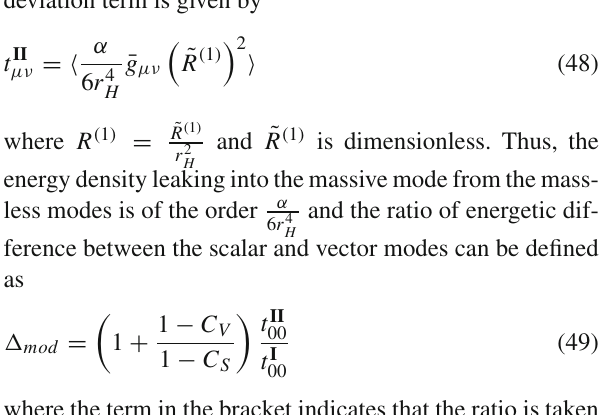
Figure 3 are plots of (cid:15) mod versus charge q and QNM frequency ω for (cid:13) = 2 and for three different horizon radii r H , whereas Fig. 4 is a 3-D plot of the same with respect to the scaled charge q and dimensionless frequency ˜ ω . Note that the behavior of (cid:15) mod is dominated by the rescaled frequency (cid:12) and has a weak dependence on Q dependence through C V / S